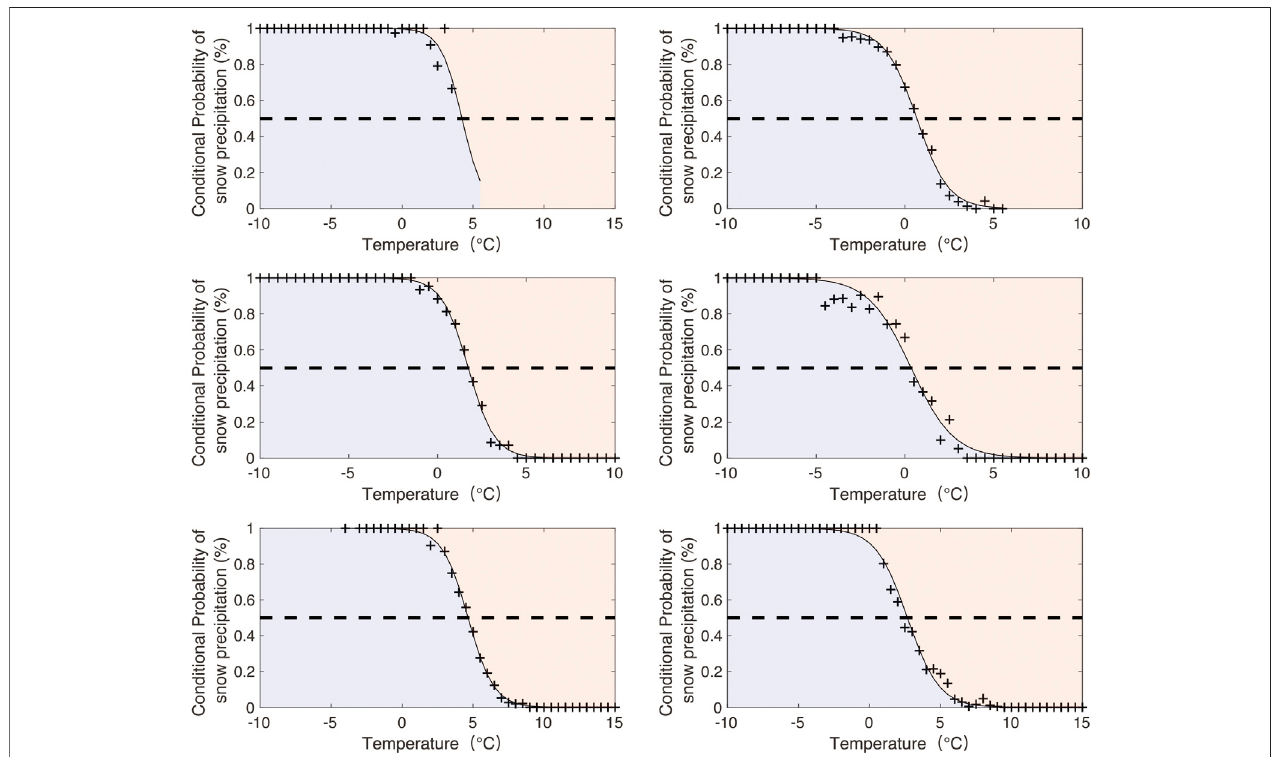
FIGURE 5 | Conditional probability of snow precipitation vs the near-surface air temperature, based on the Zhongshan, Greatwall, Barrow, Coral Harbour, Linzhi and Maqu station surface observations, with respective curvilinear fi ts (the upper half of the curve represents the conditional probability of rain precipitation; in addition, sleet was